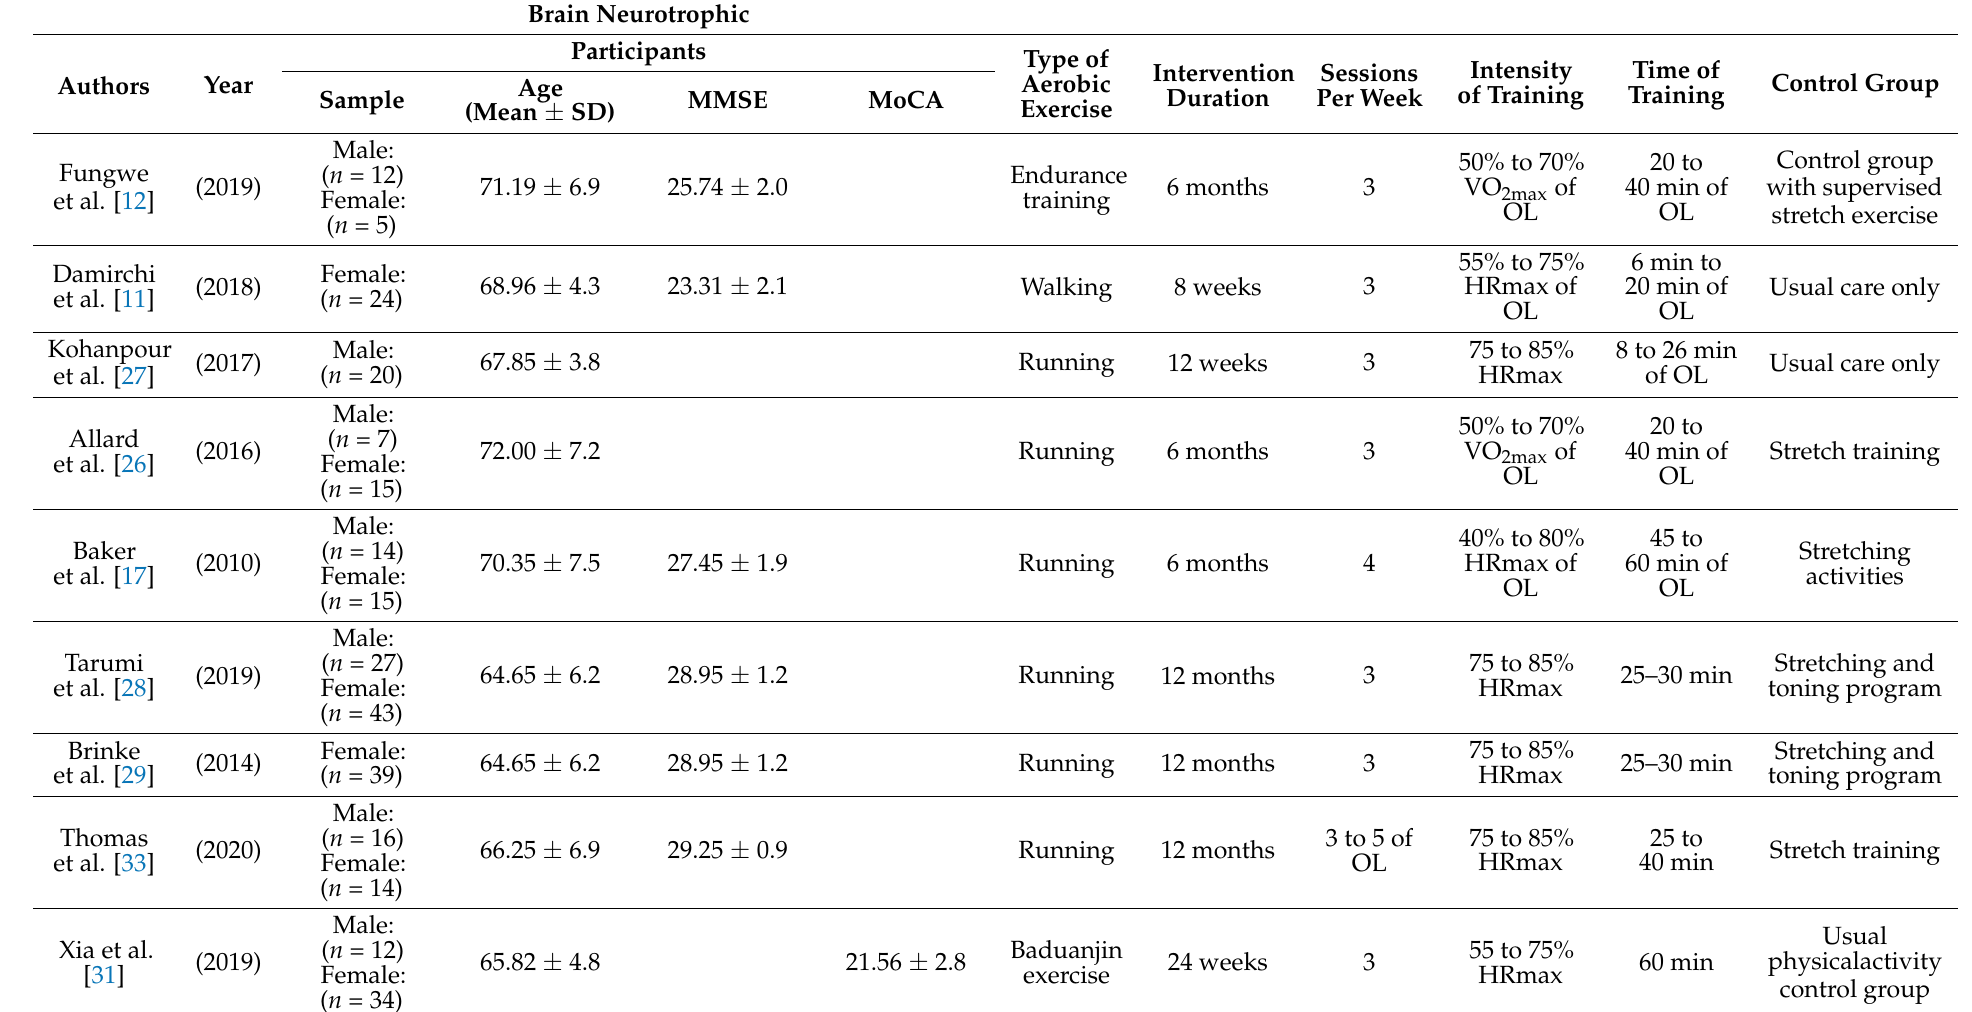
Table 1. Characteristics and protocols of the reviewed